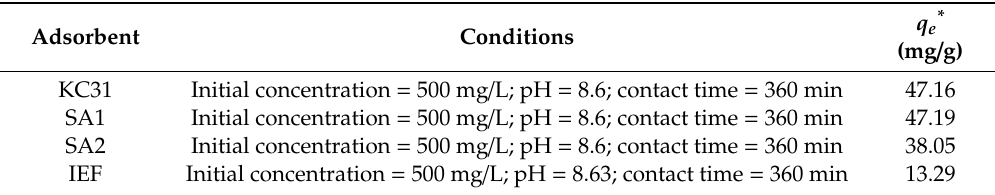
Table 2. Comparison between the As(V) adsorption capacities of the commercial ion-exchange fibers and the novel ion-exchange fabric (IEF).